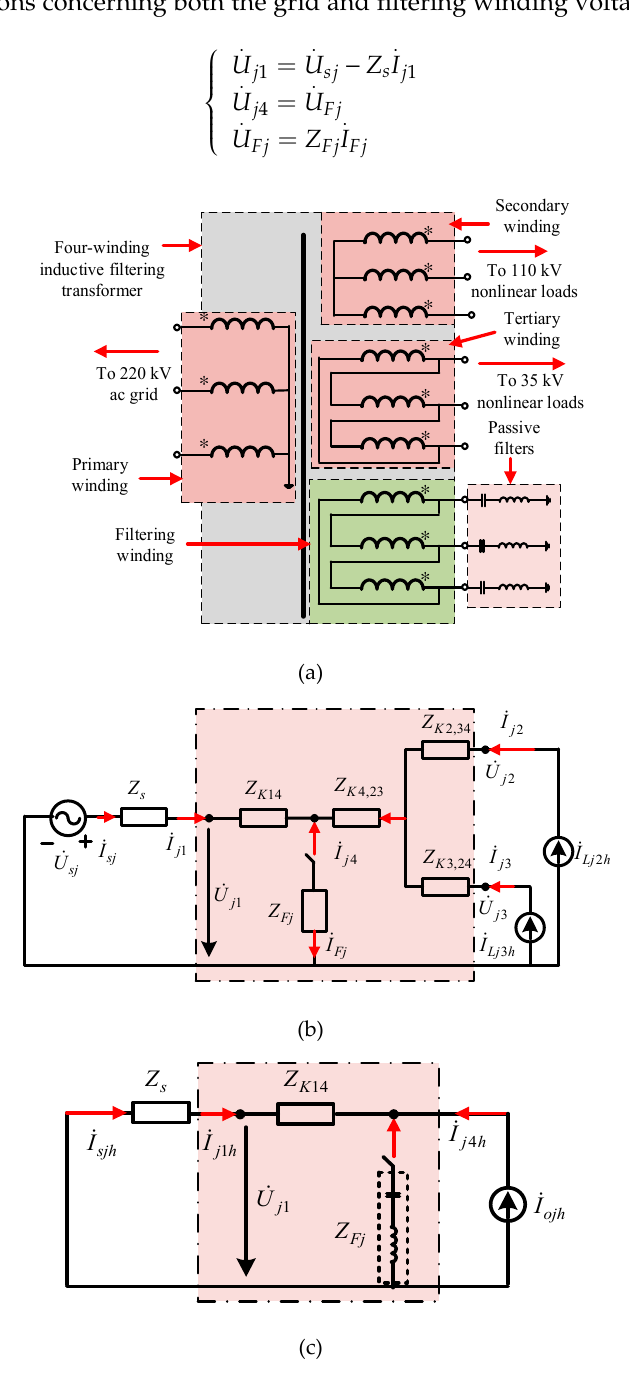
Figure 4. Structure and decoupling circuit. ( a ) Construction of the FW-IFT, ( b ) equivalent decoupling circuit model, and ( c ) simplified resistive equivalent model.